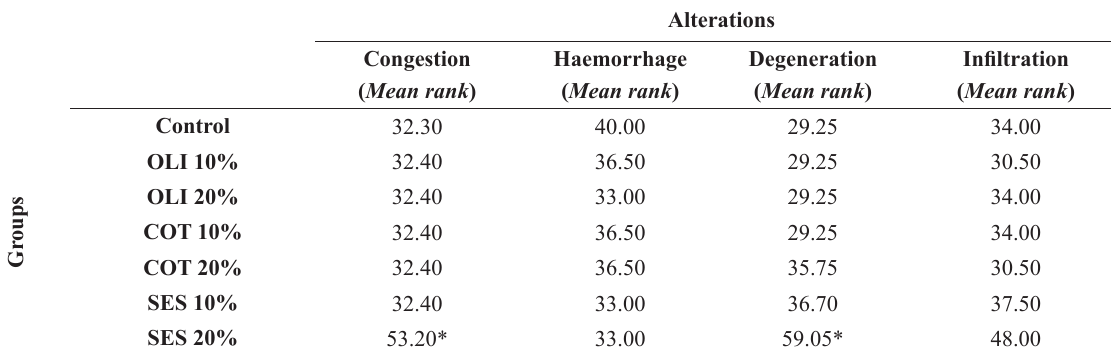
Score of histopathological changes in the kidney